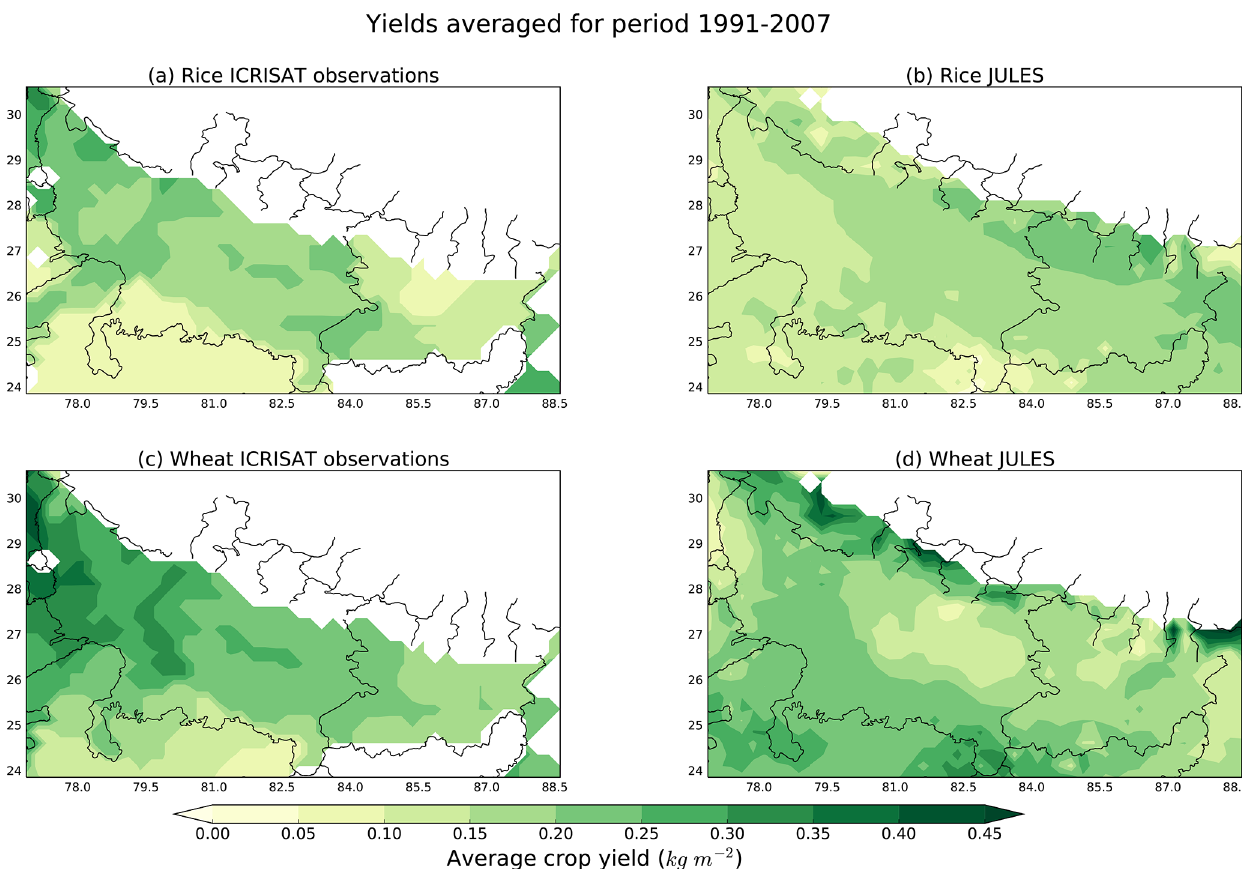
Figure C3. A comparison of observed ICRISAT (2015) rice yields (a) with JULES rice yields (b) and observed ICRISAT (2015) wheat yields (c) with JULES wheat yields (d) for the period 1991–2007 across Uttar Pradesh and Bihar. Note that the simulations assume that rice and wheat are grown everywhere and the crops are not limited by nutrient